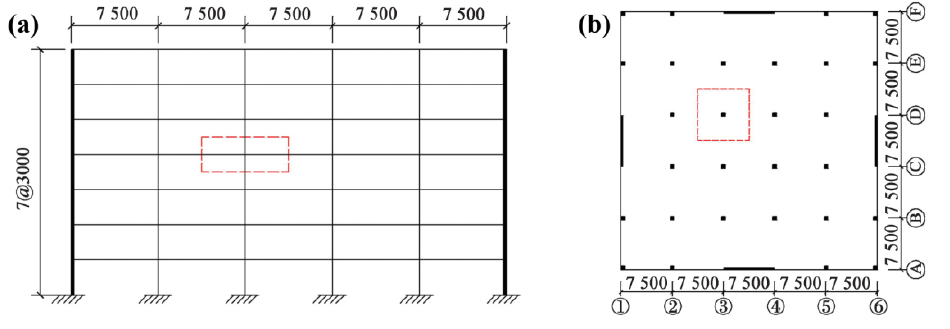
Figure 9. Prototype building [53]: ( a ) elevation; ( b ) plan. Table 4. Main influential factors of the selected interior joint.